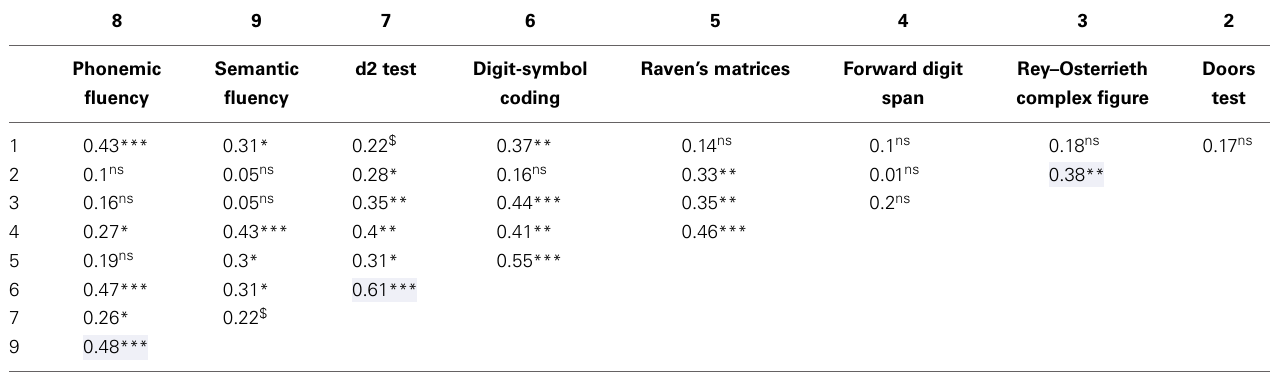
Table 3 | Pairwise correlations among the outcome measures (trend/significance p -values: $ p < 0 . 1; * p < 0 . 05; ** p < 0 . 01; *** p < 0 . 001).